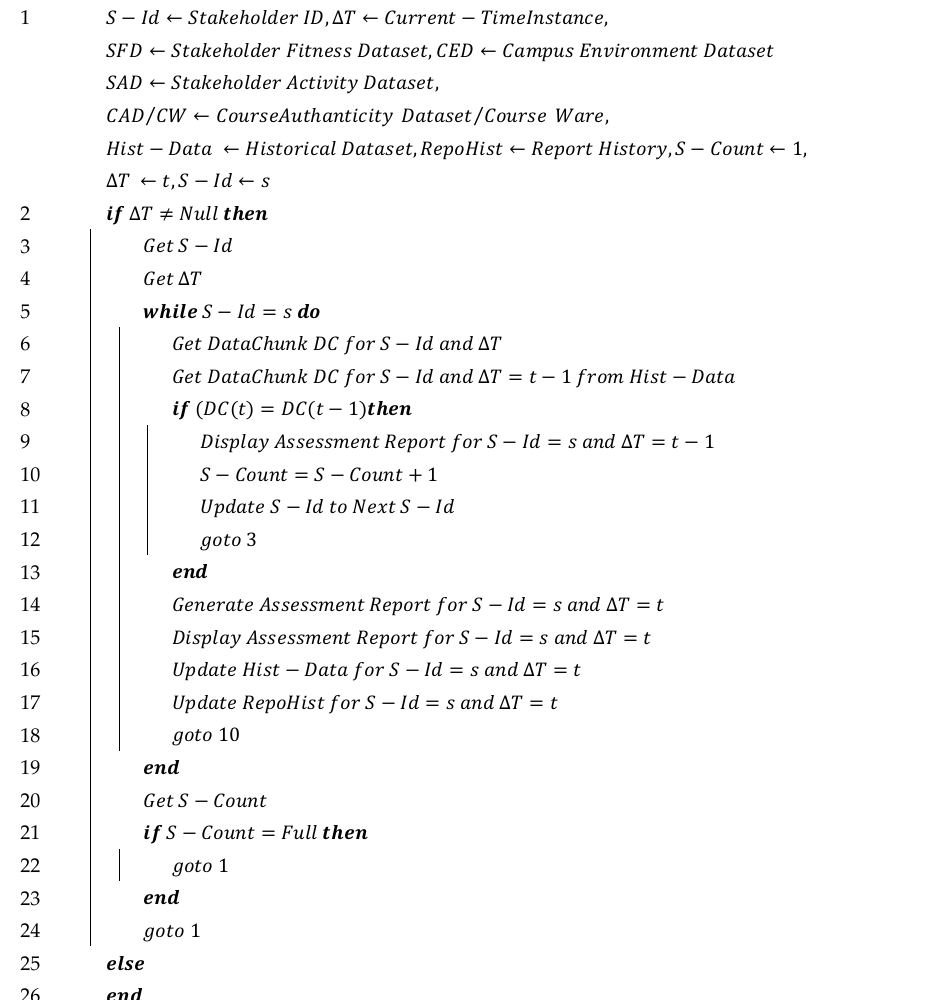
Algorithm 1: To generate the Real-Time Assessment Report